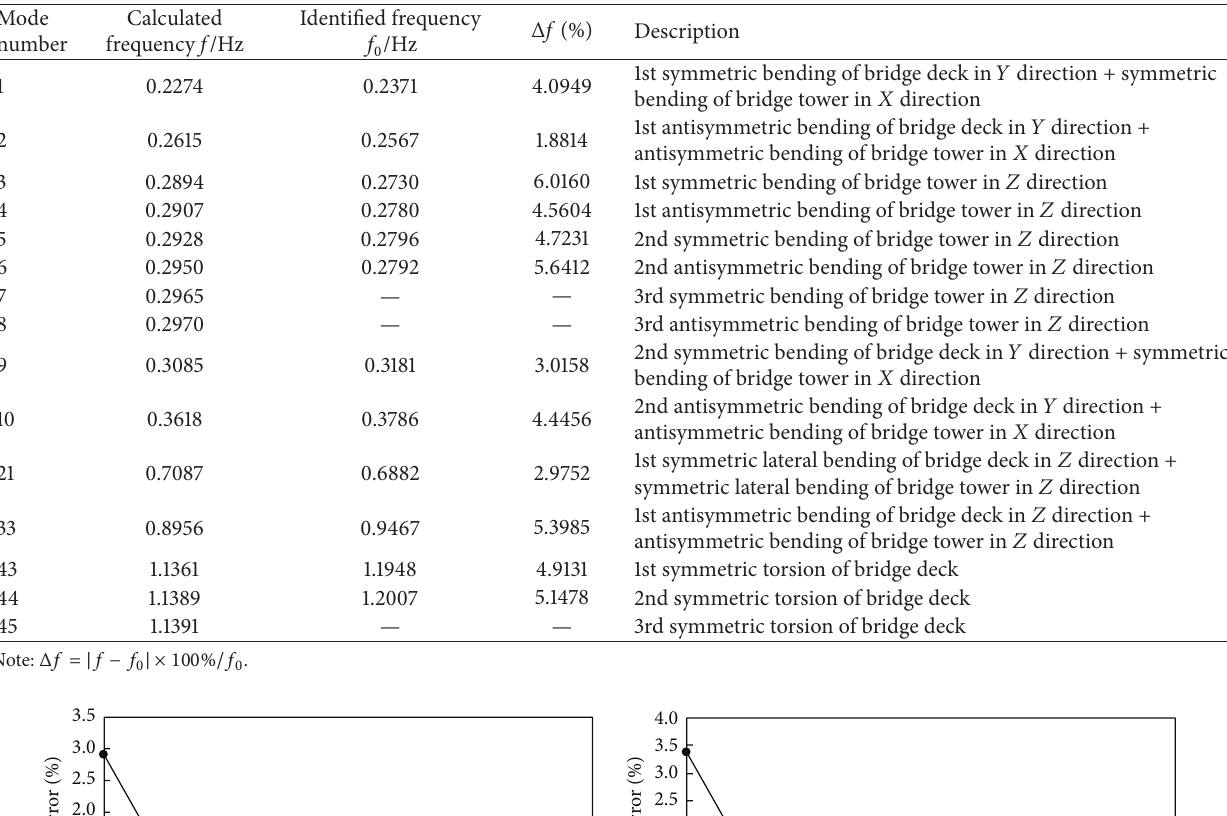
Table 1: Vibration modes of finite element model of Jiashao Bridge.